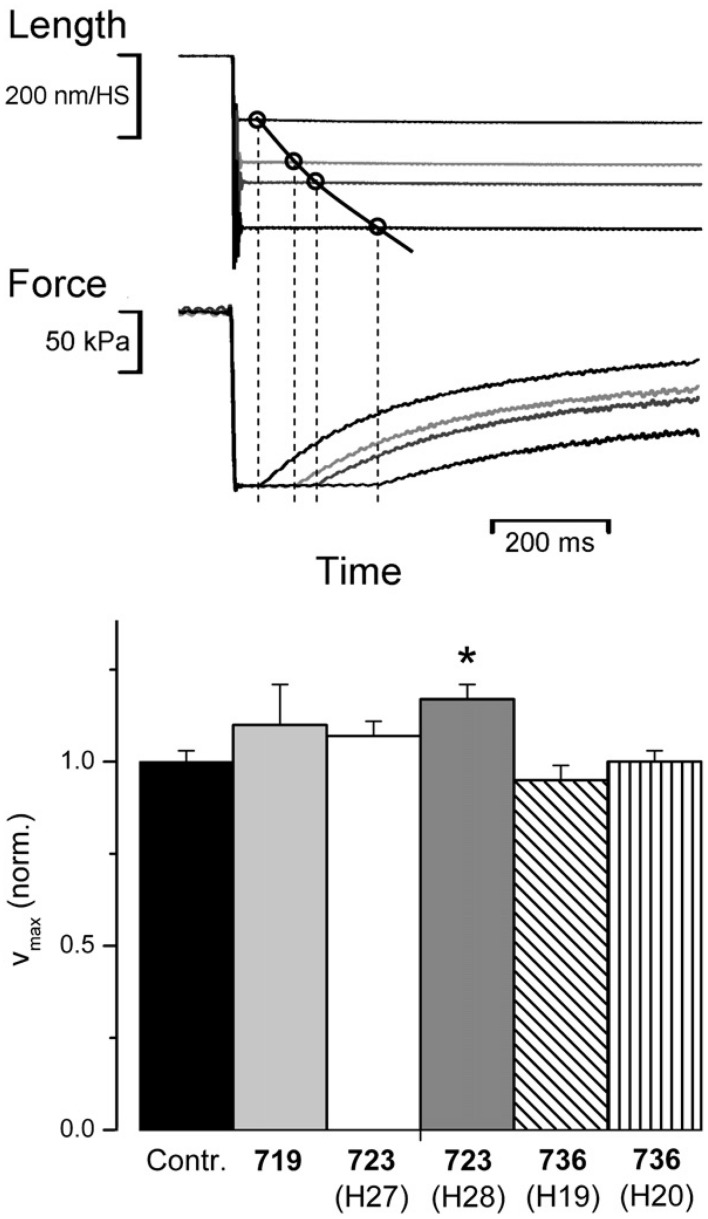
Effect of converter mutations on maximum unloaded shortening velocity (vmax). Top panel: sample traces of slack test experiment, length vs. time and force vs. time (cf. Edman, 1979). This illustrates the reconstruction of 4 points of unloaded shortening vs. time from the time required for unloaded shortening to take up the imposed slack, i.e., until force starts to redevelop; vmax defined as initial slope of the shortening curve is determined by curve fitting according to Brenner (1986). Control fiber at 20°C. Bottom panel, vmax for mutations R719W, R723G, and I736T normalized to control fibers; n = 6–11 fibers. T = 20°C; mean values ± SE. *indicates statistically significant difference to controls (p ≤ 0.05). Reprinted from Seebohm et al. (2009) with permission from Elsevier.